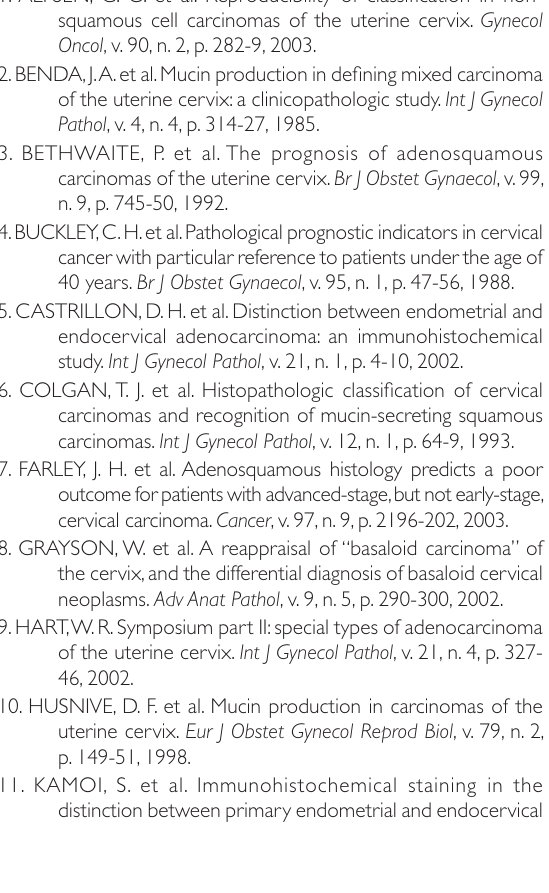
adenocarcinomas: another viewpoint. Int J Gynecol Pathol ,